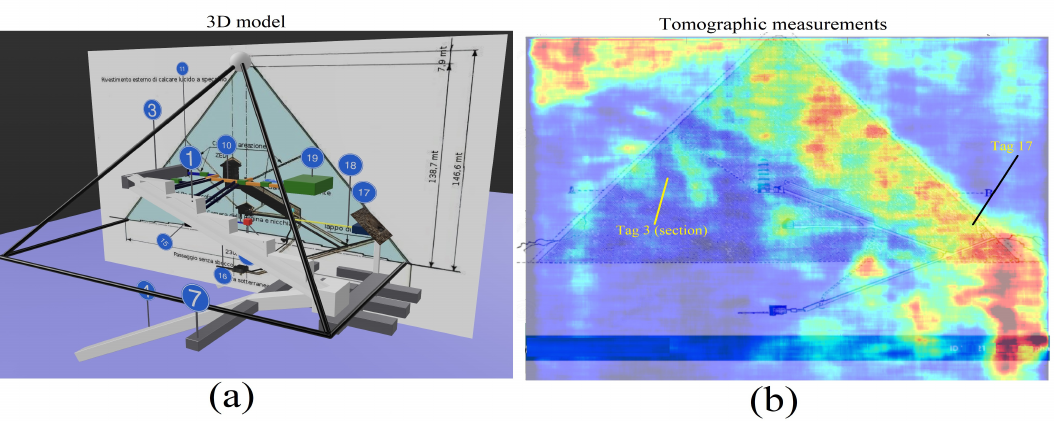
Figure 54. Tags association from tomography to 3D model. ( a ): Three-dimensional (3D) model of Khnum-Khufu. ( b ): Tomographic reconstruction (magnitude).